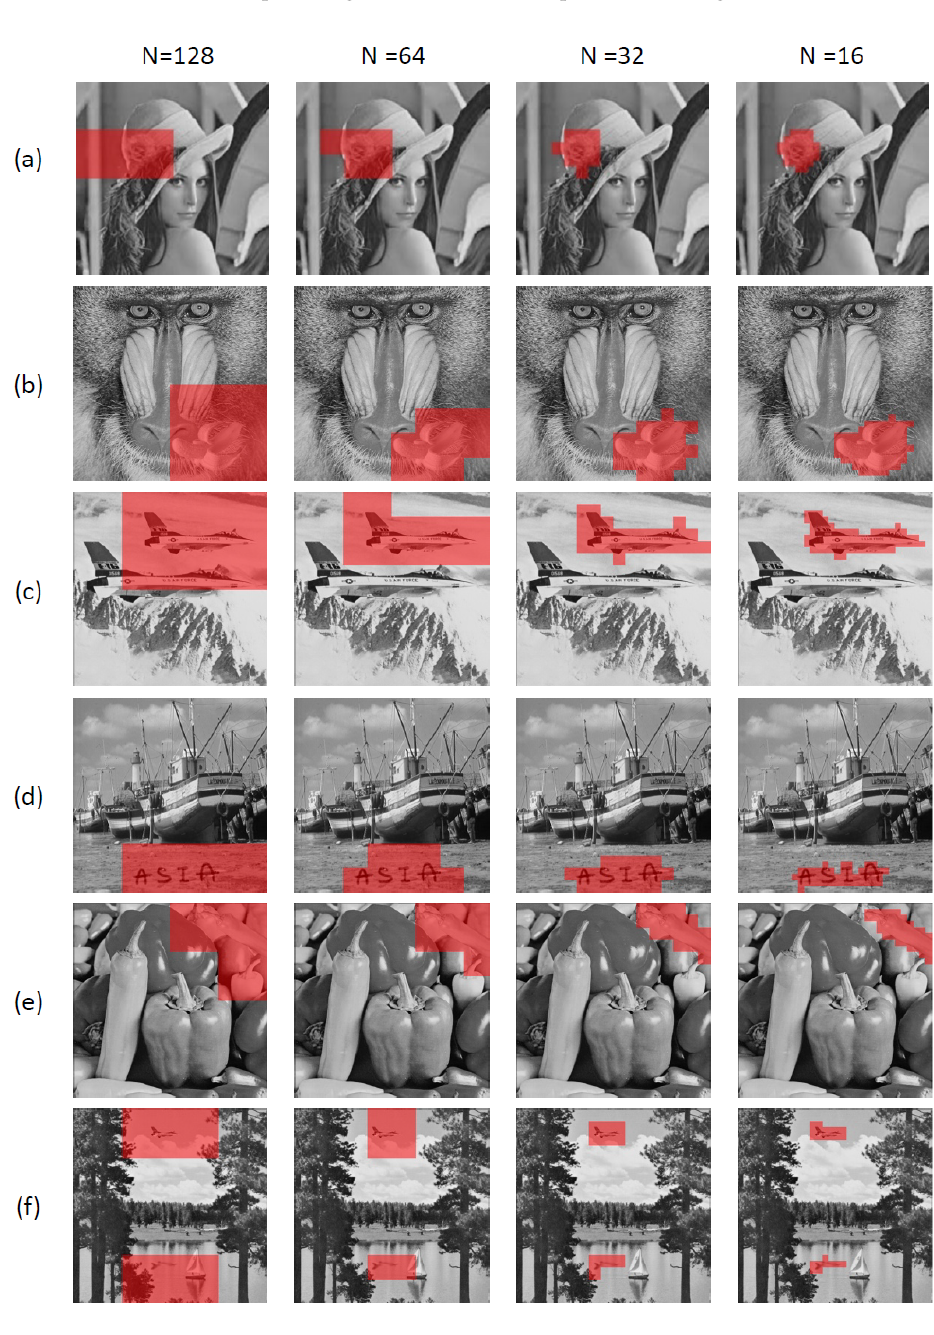
Figure 19. The result of detected tamper area with different slicing size: ( a ) Lena, ( b ) Baboon, ( c ) Jet, ( d ) Boat, ( e ) Pepper, ( f ),